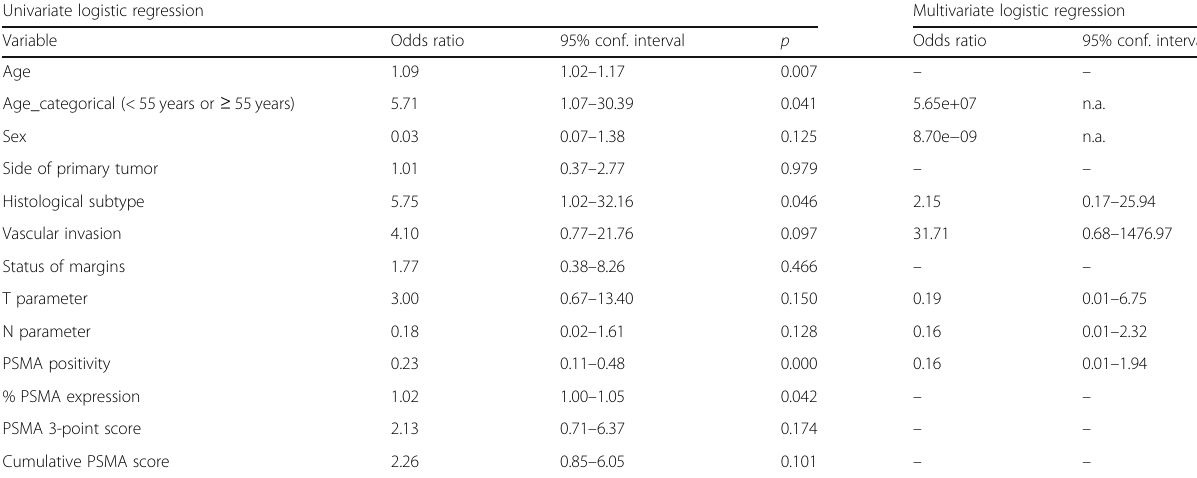
Table 3 Results of the univariate and multivariate logistic regression analysis for prediction of distant metastases at presentation in DTC Univariate logistic regression